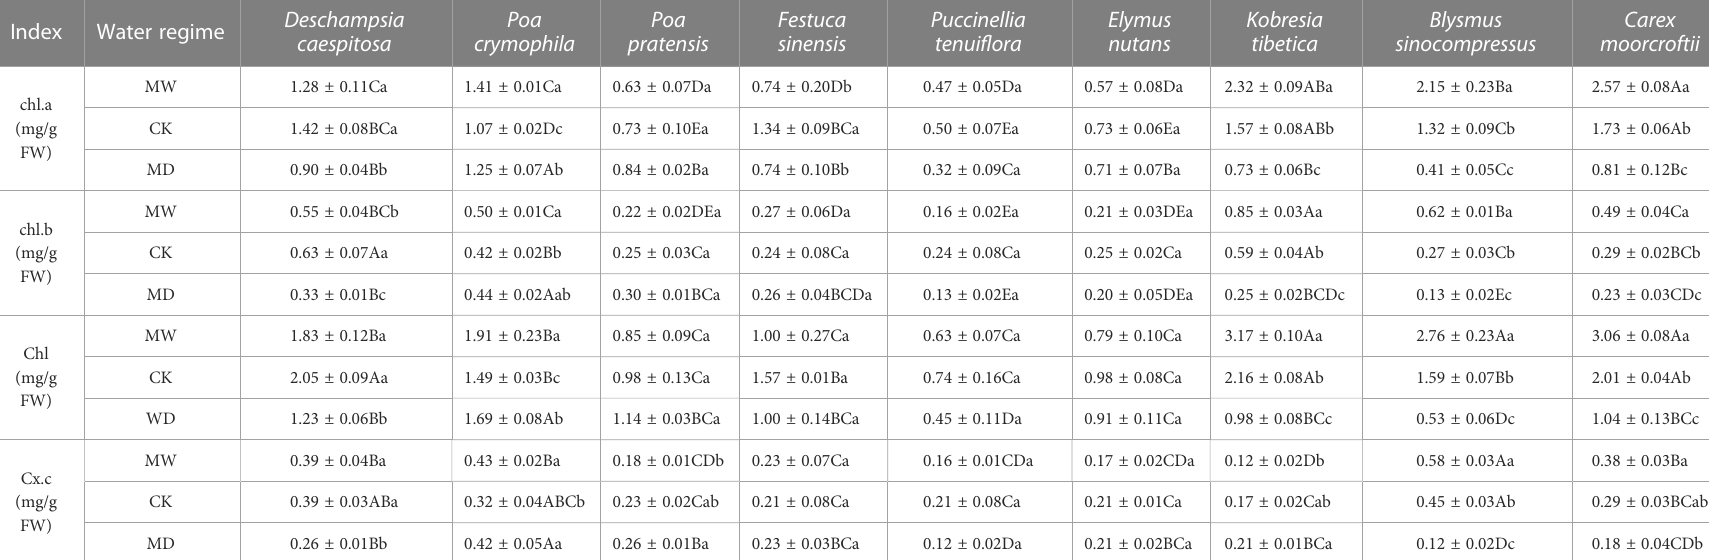
Different lowercase letters within the same row indicate that there are signi fi cant differences between water regimes for the same plant species at a =0.05; Different capital letters within the same column indicate that there are signi fi cant differences between plant species under the same water condition at a